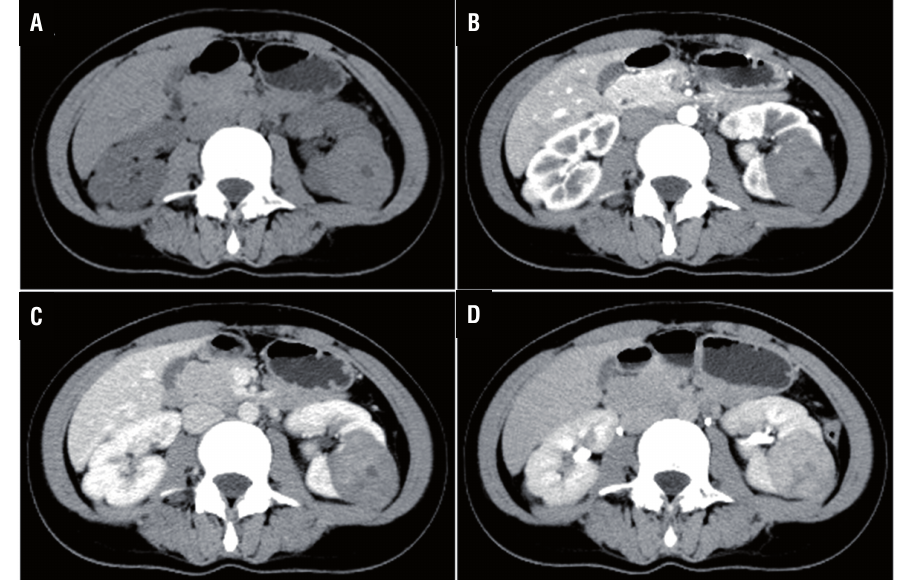
figure 1 - Enhanced computed tomography scan (cT) demonstrated a 4.5×4.0×4.5cm neoplasm in the middle and dorsal part of left kidney (cT unit: 45). It had a clear boundary and part of the neoplasm extruded the renal contour. Multiple patchy low density area could be seen in the neoplasm (cT unit: 10). The neoplasm was lightly enhanced in the arterial phase (cT unit: 57.2), and it was continuously enhanced in the venous (cT unit: 68.9) and excretory phase (cT unit: 88.8). The low density area did not show any enhancement.